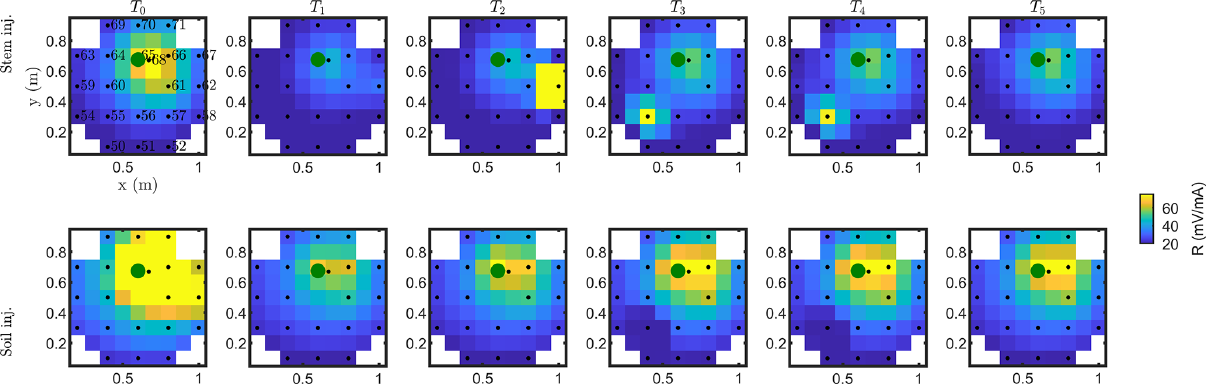
Figure C1. Resistance distribution of the raw data of MALM time-lapse monitoring for plant B. First-line results are relevant to the stem injection, while the second line refers to the soil control injection. Columns describe time evolution according to Table 1.